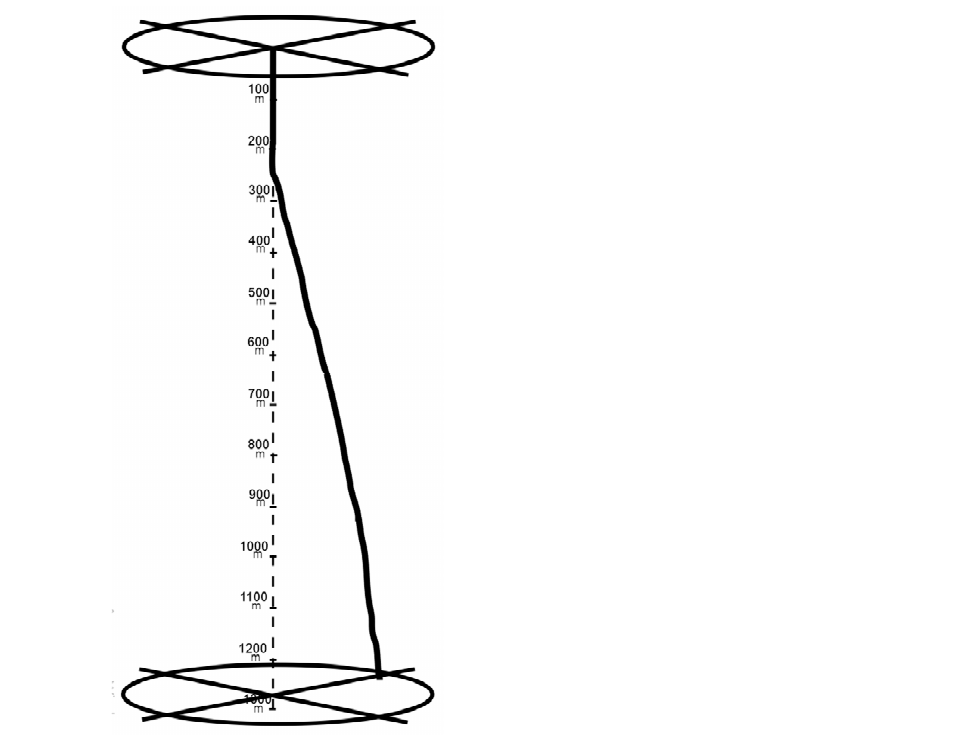
Figure 4. Axonometric projection of well 3633 operated by JSC Ideloil.